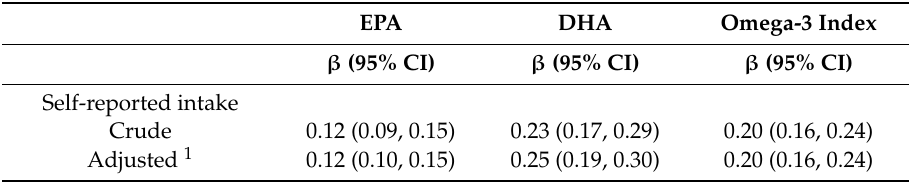
Figure 3. Scatterplots of blood levels of EPA, DHA, and omega-3 index by self-reported intake, respectively. Yellow dots were reported from volunteers with a self-reported habitual weekly intake of EPA + DHA ≤ 0.5 g, red dots were reported from volunteers with a self-reported habitual weekly intake of EPA + DHA between 0.5 to 3 g, blue dots were reported from volunteers with a self-reported habitual weekly intake of EPA + DHA ≥ 3 g. Regression lines were added in the figure.